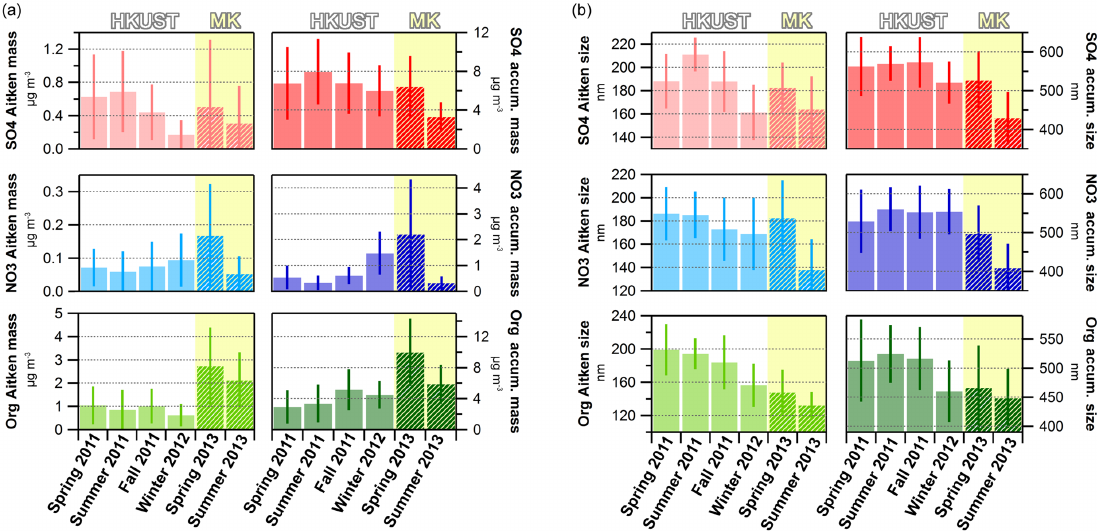
Figure 5. Average and standard deviation of daily fit values of Aitken- and accumulation-mode particle mass and mass median diameters at the suburban HKUST site (solid bars) and urban MK site (hashed bars). The integrated particle mass is depicted in (a) for the Aitken mode (left panels) as well as the accumulation mode (right panels) for sulfate, nitrate, and organics. The mass median diameter is depicted in (b) for the Aitken mode (left panels) as well as the accumulation mode (right panels) for sulfate, nitrate, and